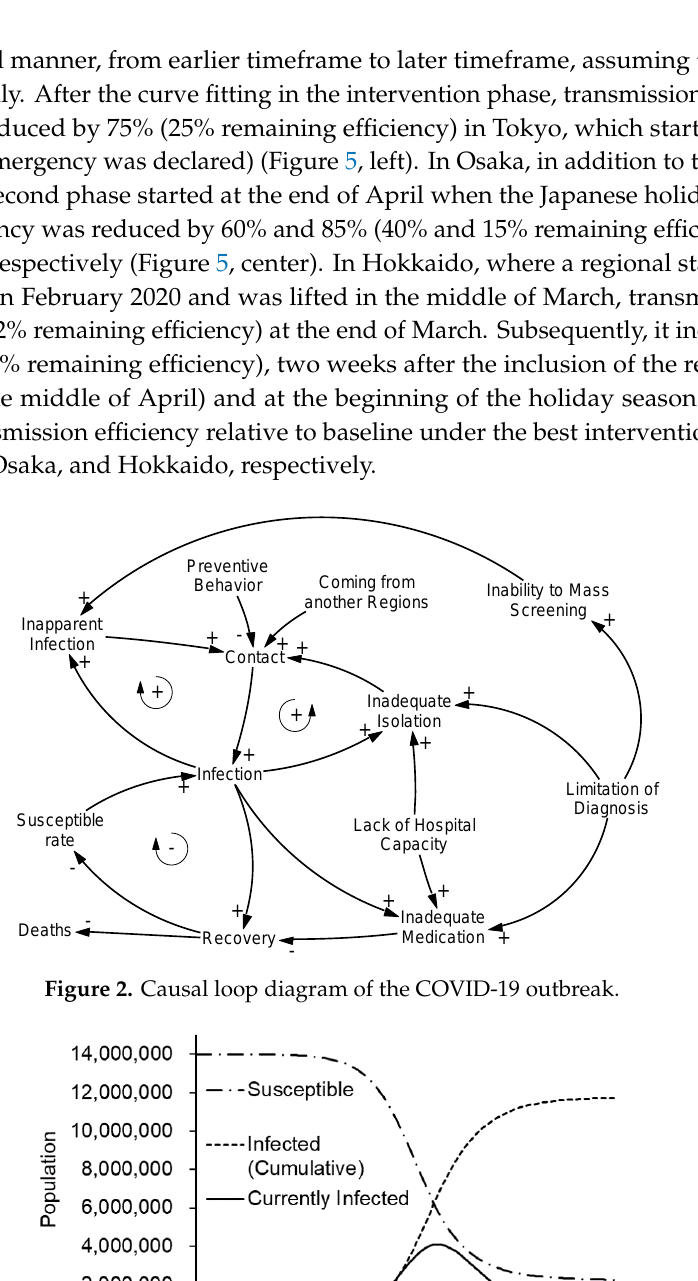
Figure 3. Simulation of the COVID-19 outbreak without intervention (Tokyo case).